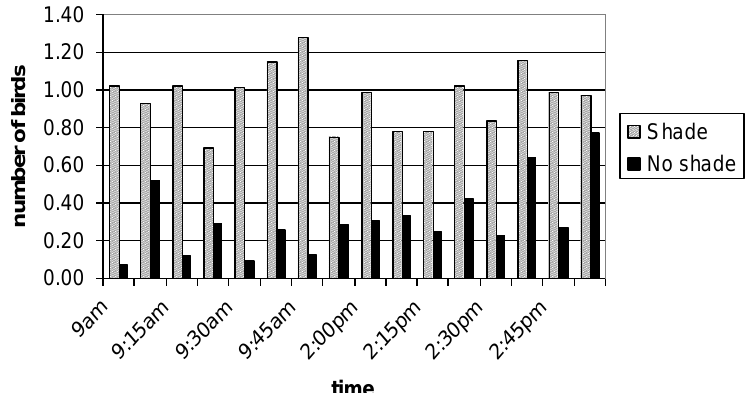
Figure 1. Average number of birds in shade and non shade areas over a day.